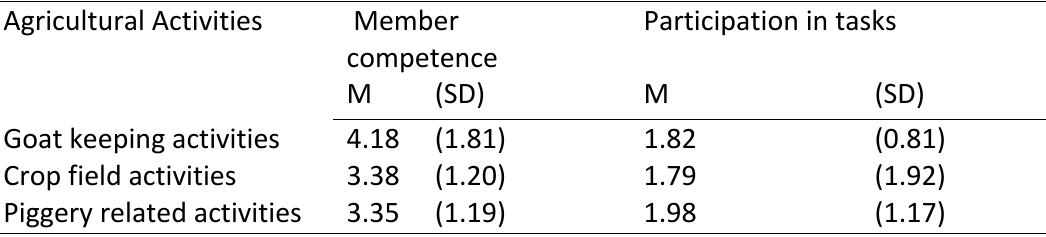
Members’ Competence and Participation in Agricultural